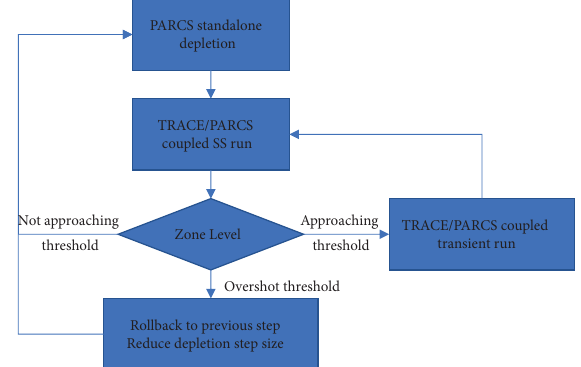
Figure 2: Summary of hybrid methodology for performing a shim